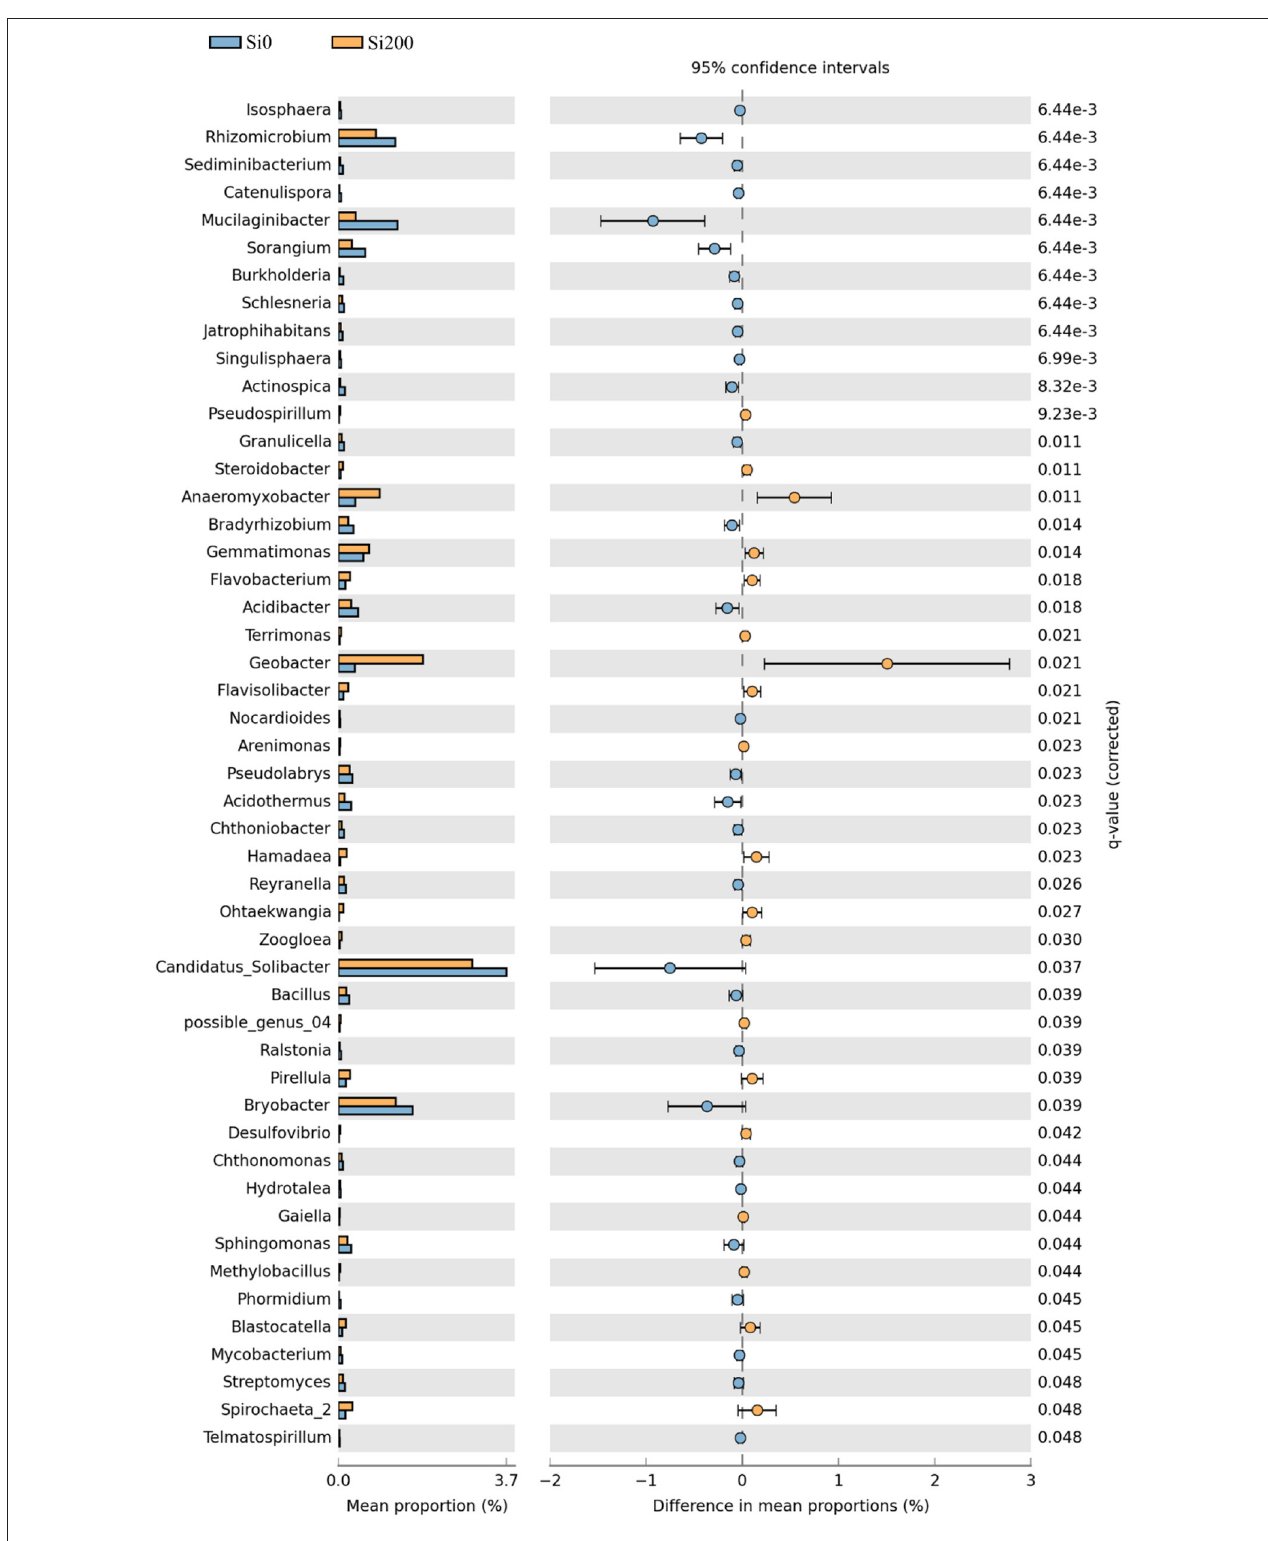
FIGURE 4 | Topological properties of bacterial networks obtained from the rhizospheres of the two silicon (Si) treatments. Corrected P -values were calculated using the Story false discovery rate approach ( P < 0.05).